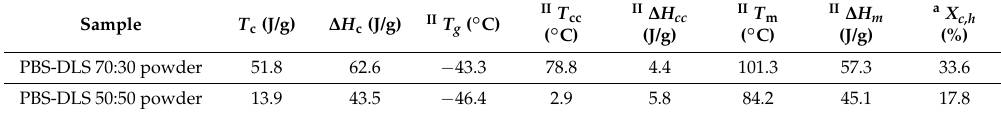
Table 2. Thermal behavior of PBS-DLS 70:30 and 50:50 copolymers as synthesized (powder).